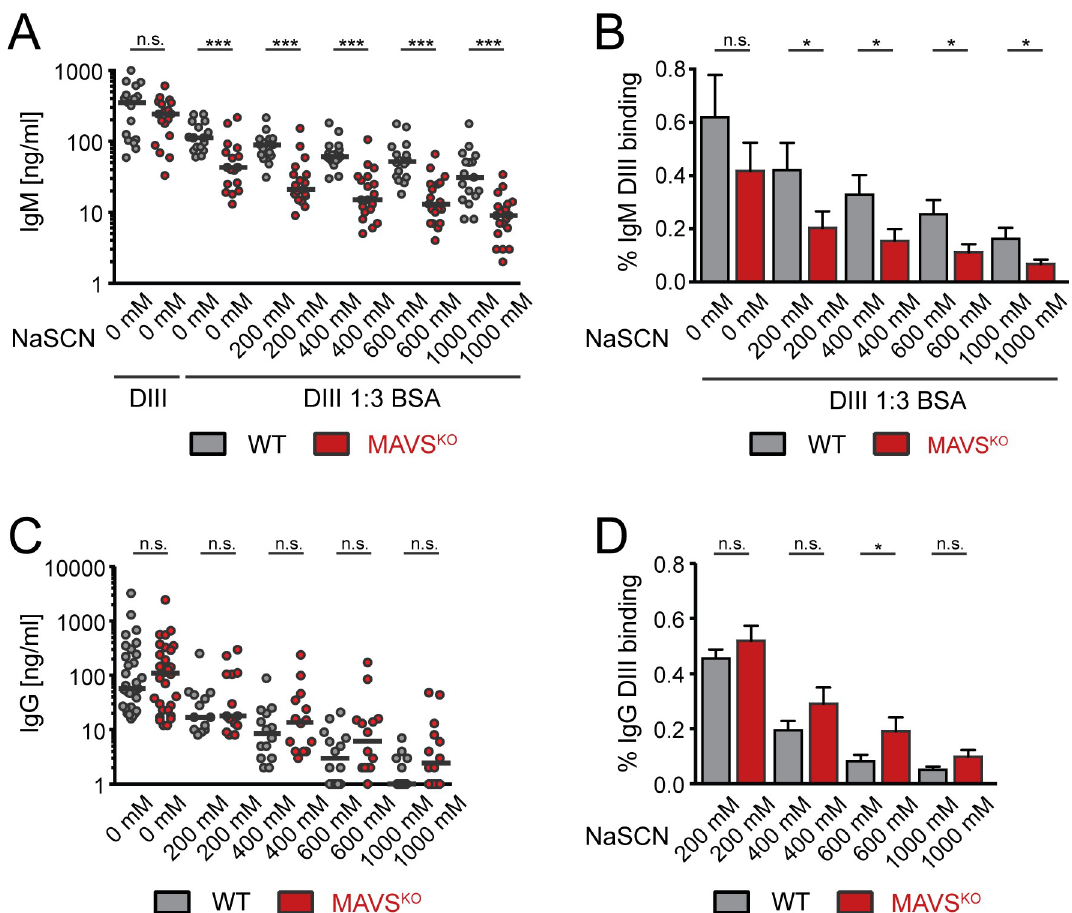
Fig 7. Impaired avidity of the IgM response to the DIII domain of WNV-E protein in RWN-infected MAVS KO mice. (A, B) DIII- specific IgM titers from RWN-infected mice were measured by ELISA in the presence of BSA to reduce binding avidity and increasing amounts of NaSCN to enhance stringency of binding. Recombinant DIII protein was used as antigen. Shown are the absolute titers (A) and the titers as fraction of the total amount of DIII-specific antibodies in the absence of BSA and NaSCN for each mouse (B). (C, D) Same as before for DIII-specific IgG. Shown are the combined data of 4 experiments. Each dot represents one mouse, the line is the median. � , p < 0.05; ��� , p < 0.0005; n.s., not significant; Mann-Whitney test.